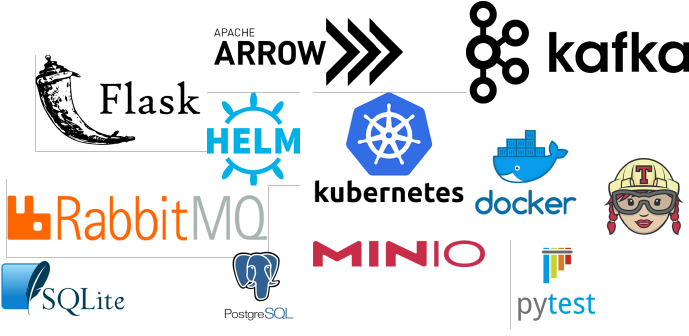
Figure 3. Multiple open-source technologies were used in the development of